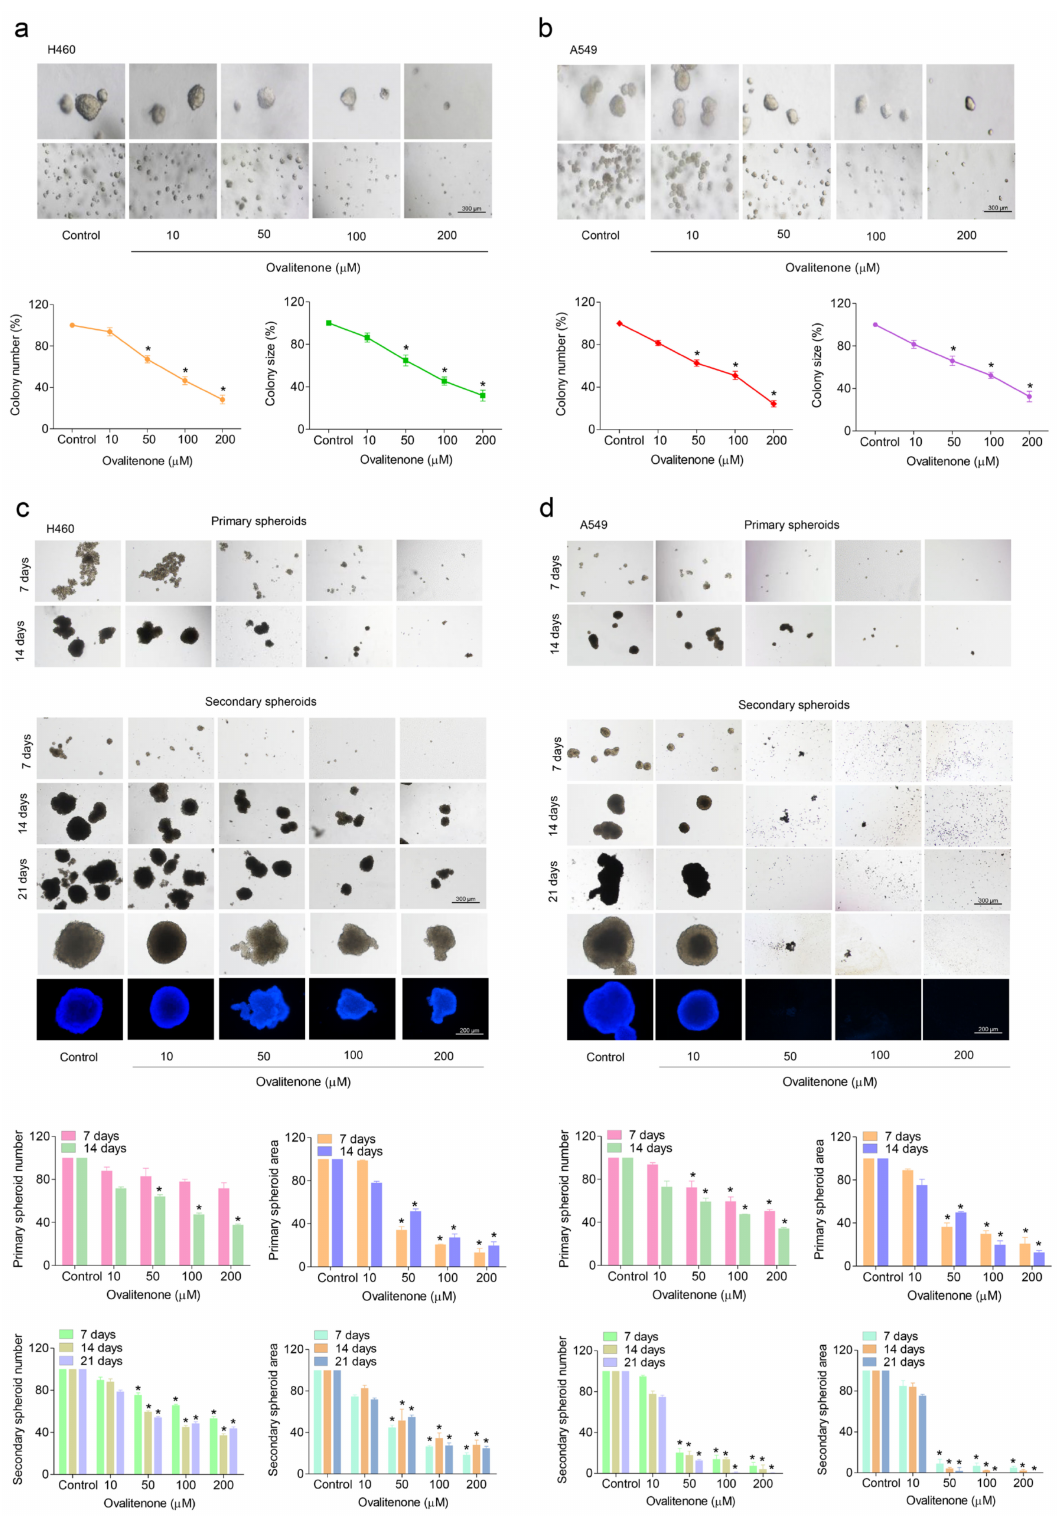
Figure 3. Ovalitenone attenuates anchorage-independent growth and cancer stem cell (CSC)-like phenotypes of human lung cancer H460 and A549 cells. ( a , b ) Cells were pre-treated with sub-toxic concentrations of ovalitenone for 24 h, and were subjected to an anchorage-independent growth assay. ( c , d ) Cells were pre-treated with non-toxic concentrations of ovalitenone for 24 h, and allowed for 14 days to form primary spheroids. After, the primary spheroids were suspended into single cells to form secondary spheroids for 21 days, the spheroid of cancer stem cell (CSC)-rich population was determined. All data are represented as mean ± SEM ( n = 3). * p < 0.05 compared with untreated